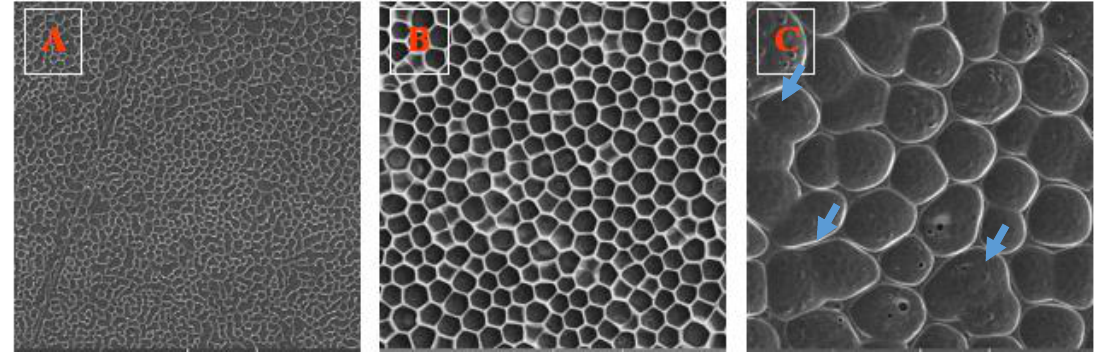
Figure 2. The images (100 × 100 µm 2 ) obtained from scanning electron microscopy (SEM) of fluorinated ethylene propylene (FEP) foils modified at 8 W and 240 s, and then immersed into polymer solution containing ( A ) 1 g, ( B ) 2 g, and ( C ) 3 g of PLLA. Missing pore walls are indicated with arrows (selected ones).